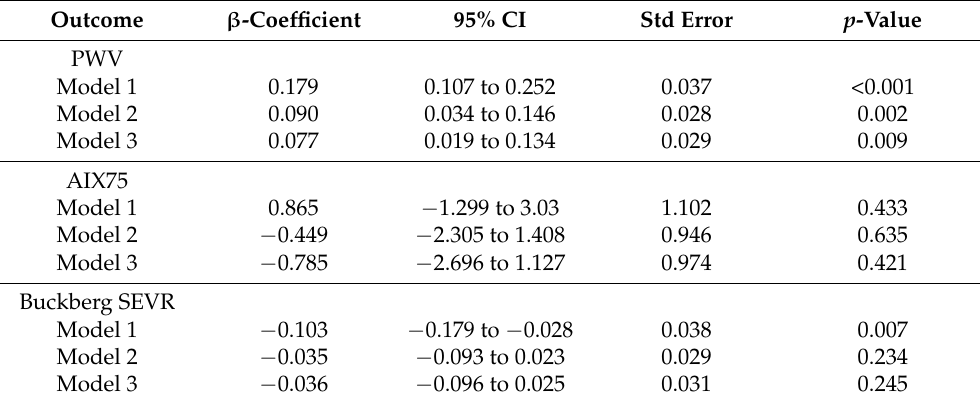
Figure 2. ( A – C ) Diabetes status has a positive association with PWV and AIX75 and a negative association with Buckberg SEVR. ( D – F ) According to BIC minimization, the best relationships of HbA1c are cubic for PWV, quadratic for AIX75, and linear for Buckberg SEVR. Given that the cubic relationship between HbA1c and PWV declined after adjusting for covariates, we present the regression analysis for PWV as a linear relationship. Abbreviations: PWV: Pulse-wave velocity. AIX75: Heart-rate-corrected augmentation index at 75 bpm. SEVR: Subendocardial viability ratio. BIC: Bayesian information criterion. Table 2. Associations between HbA1c and pulse-waveform analysis measurements by multiple regression